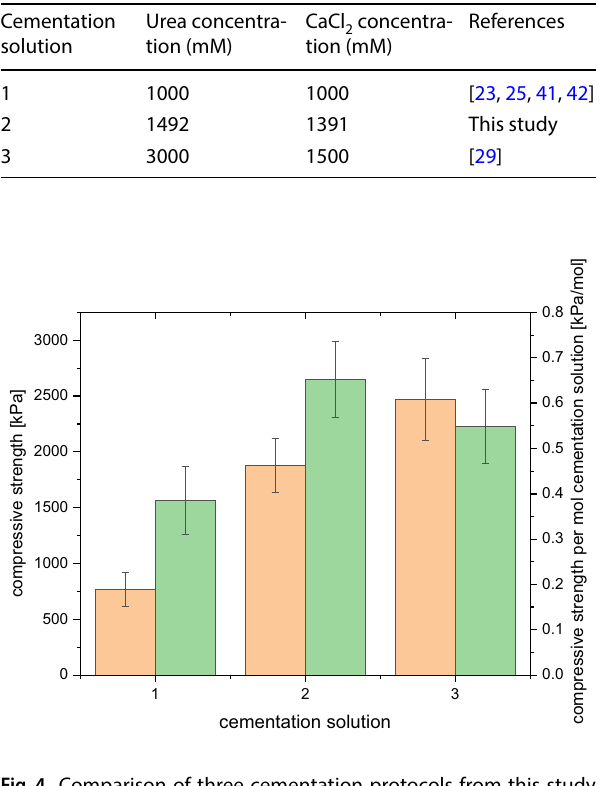
Fig. 4 Comparison of three cementation protocols from this study and with literature values. Proportion of cell suspension 7.47 mL, reaction temperature: 30 °C, reaction time 24 h, measurement with penetrometer, n =